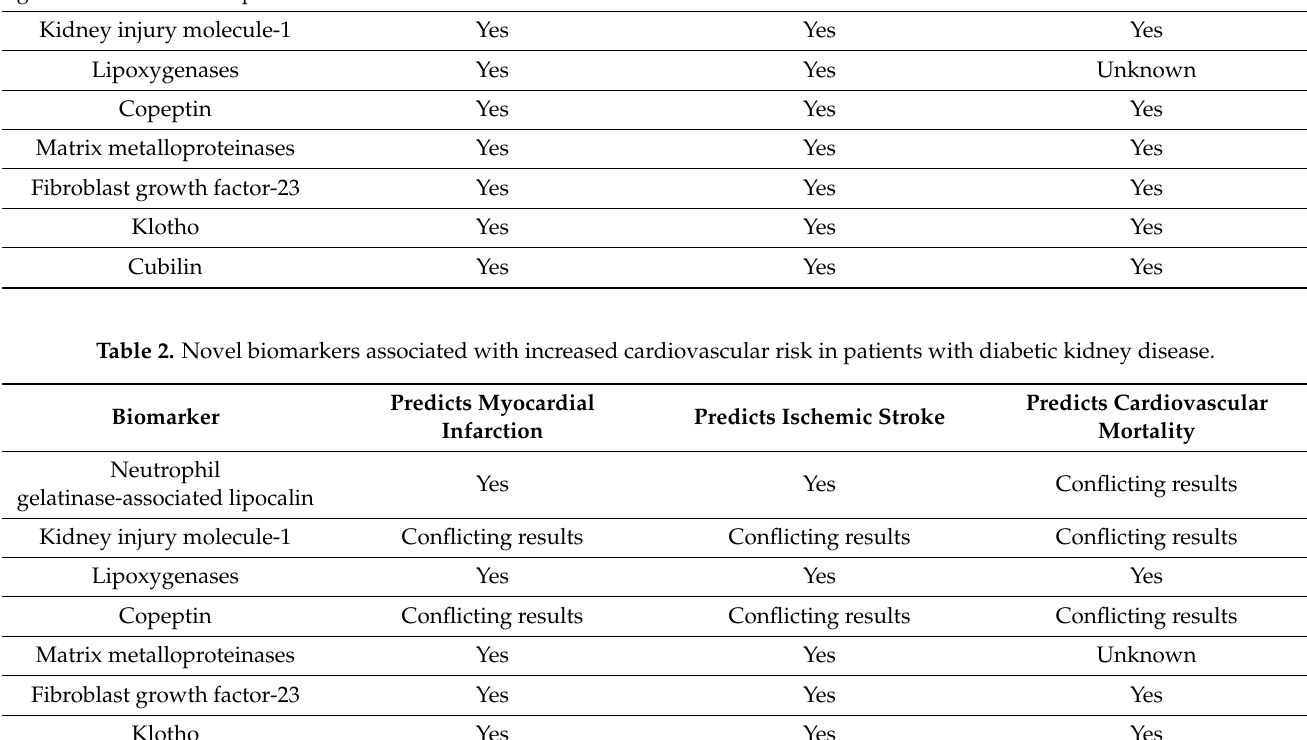
Table 1. Novel biomarkers associated with kidney damage in patients with diabetic kidney disease. Correlates with Glomerular Correlates with Urinary Biomarker Filtration Rate